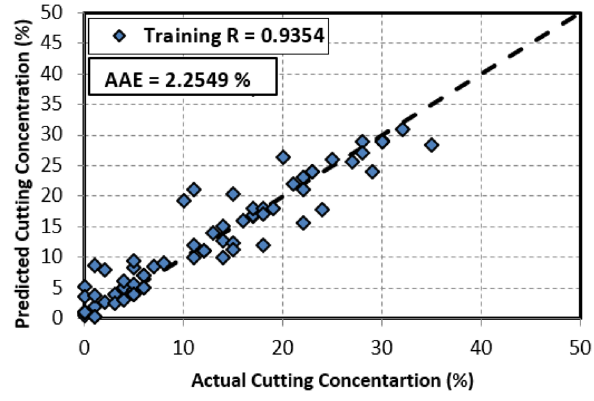
Fig. 15 SVM-predicted versus actual (experimental) cutting concen- tration from training